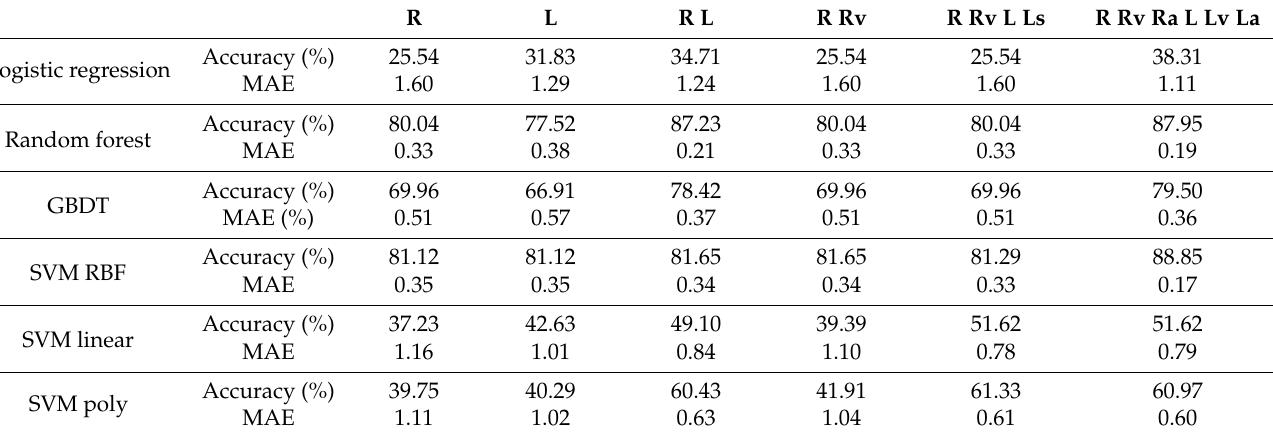
Table 2. Performance of hip joint angle, angular velocity and angular acceleration sequences in different models.